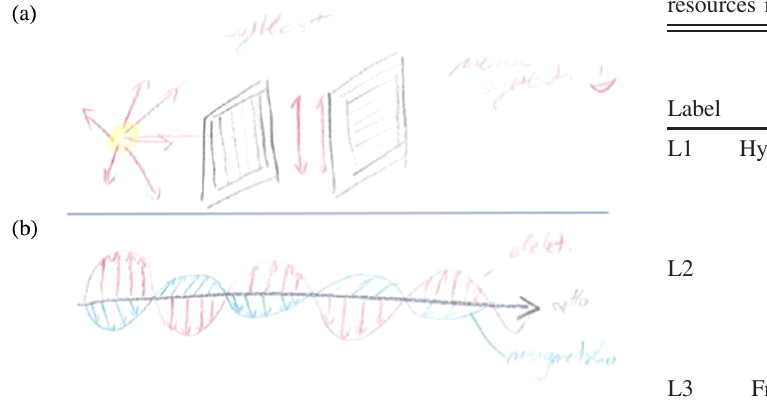
FIG. 10. (a) The drawing of the experiment with two polarizers by student S10_VG. (b) Light as an EM wave. The red curve is an electric field, and the blue curve is the magnetic field.